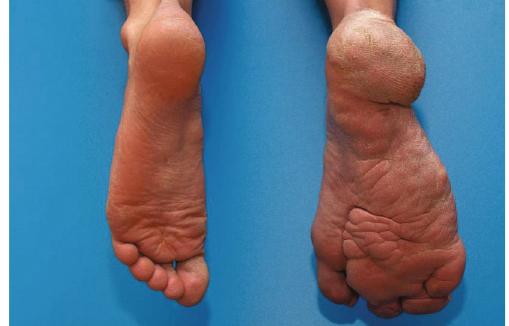
Figure 2: Photograph of the plantar surface of the patient ’ s bilateral feet, demonstrating the multiple invaginations and skin folds on the plantar right